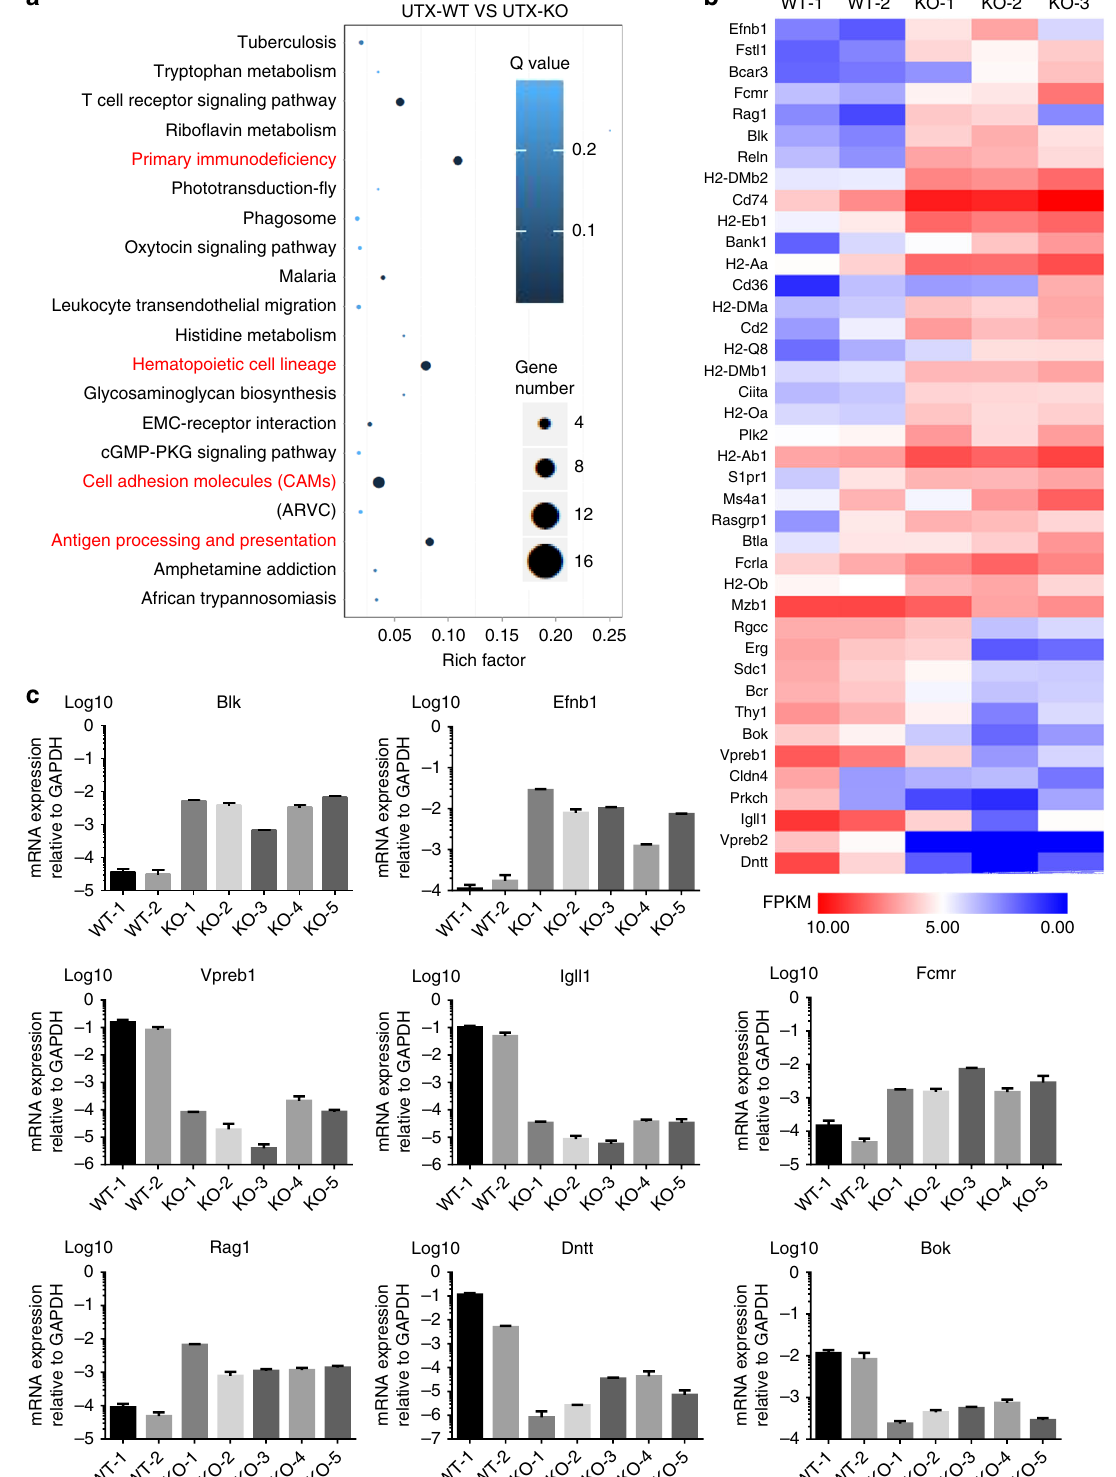
Fig. 3 Genes involved in B cell biology and cell adhesion are differentially expressed in UTX KO lymphomas. a Top 20 of enriched pathway of differentially expressed genes (DEGs) in UTX KO lymphomas. RichFactor is the ratio of differentially expressed gene numbers annoted in this pathway term to all gene numbers annoted in this pathway term. Qvalue is corrected p-value ranging from 0 – 1, and less Qvalue means greater intensiveness. b Representative DEGs involved in B cell biology and tumor development. FPKM method is used in calculated expression level. c QPCR con fi rmation of DEGs ’ expression in UTX WT and KO lymphomas. Shown are mean ± SEM from three independent